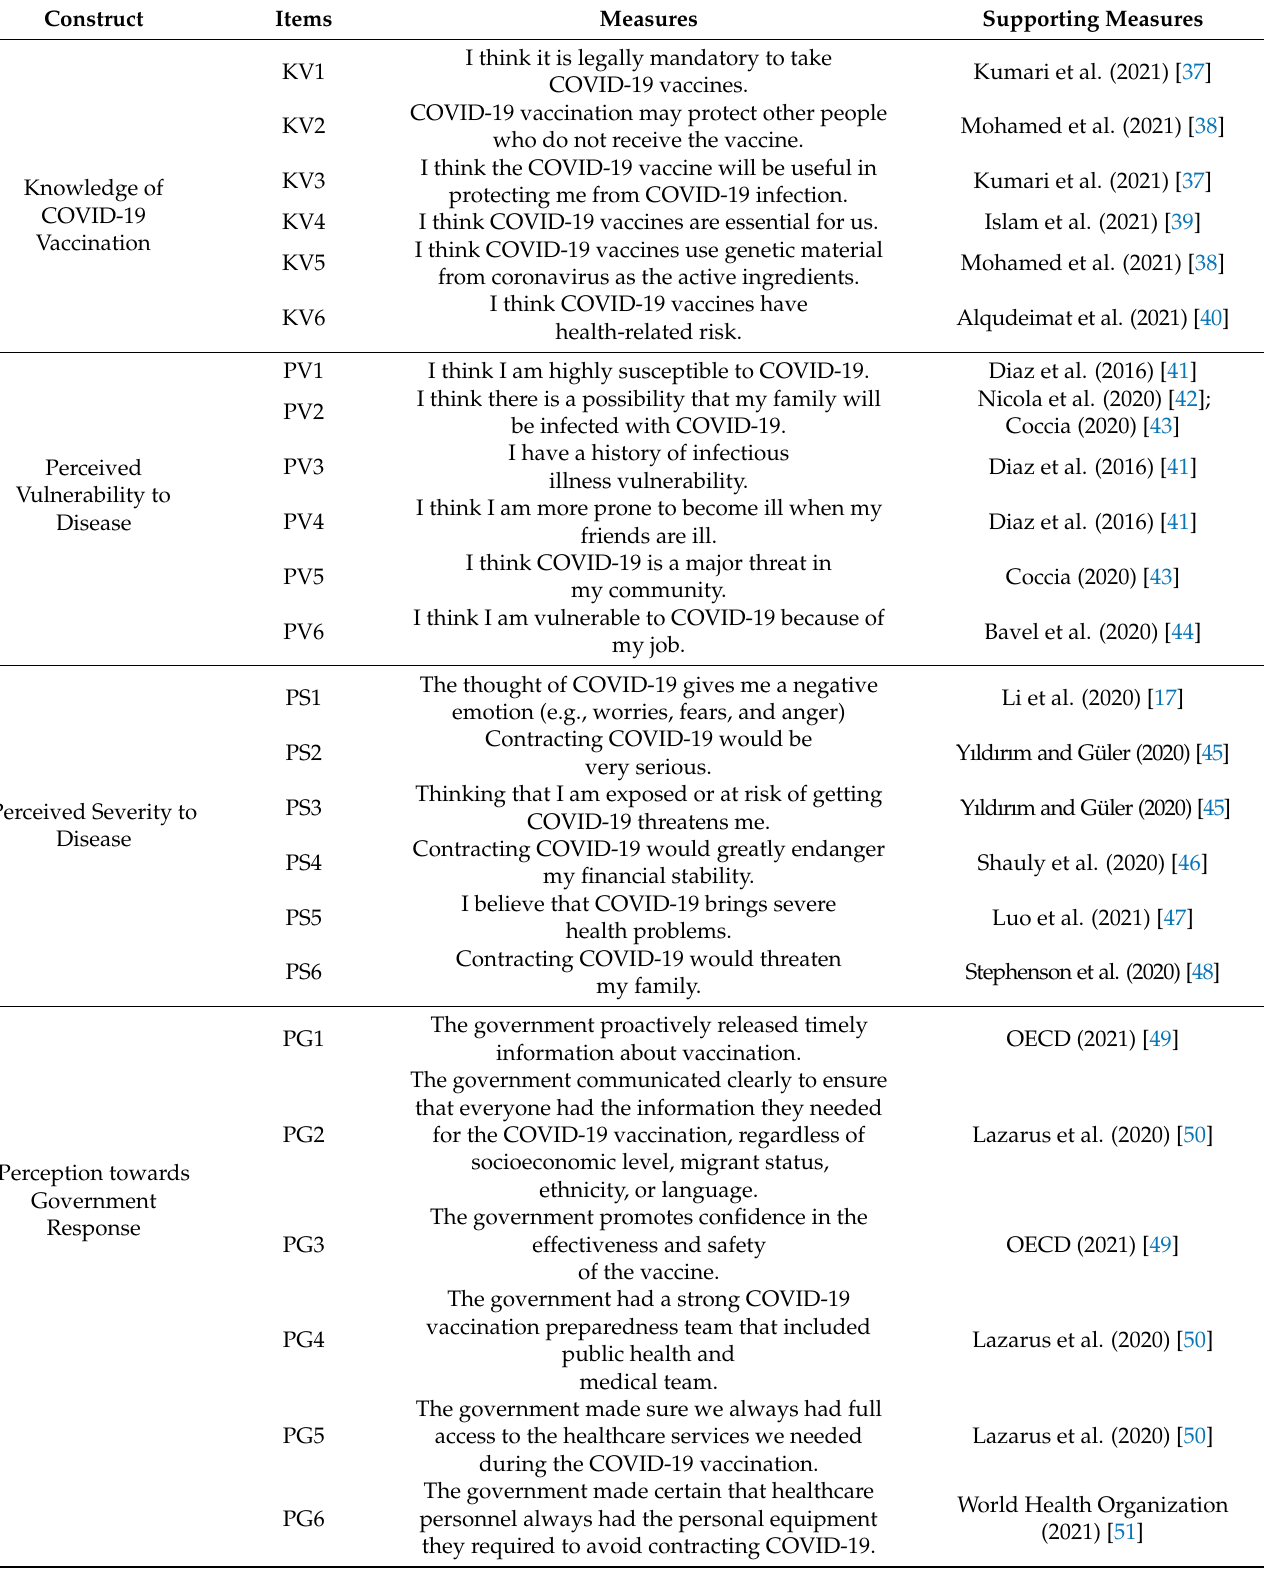
Table 2. The constructs and measurement